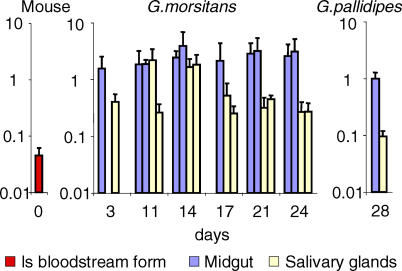
Relative Amount of Procyclin mRNA in Different Life Cycle StagesRTQ-PCR was performed on RNA samples from bloodstream forms and midgut and salivary gland trypanosomes at various days post infection. β-tubulin was used as an internal control. The ratio of procyclin/tubulin mRNAs in a reference culture of procyclic forms was set at 1. Standard deviations derive from two to five replicas. RNA derived from independent infections (days 11–24) was quantitated separately.